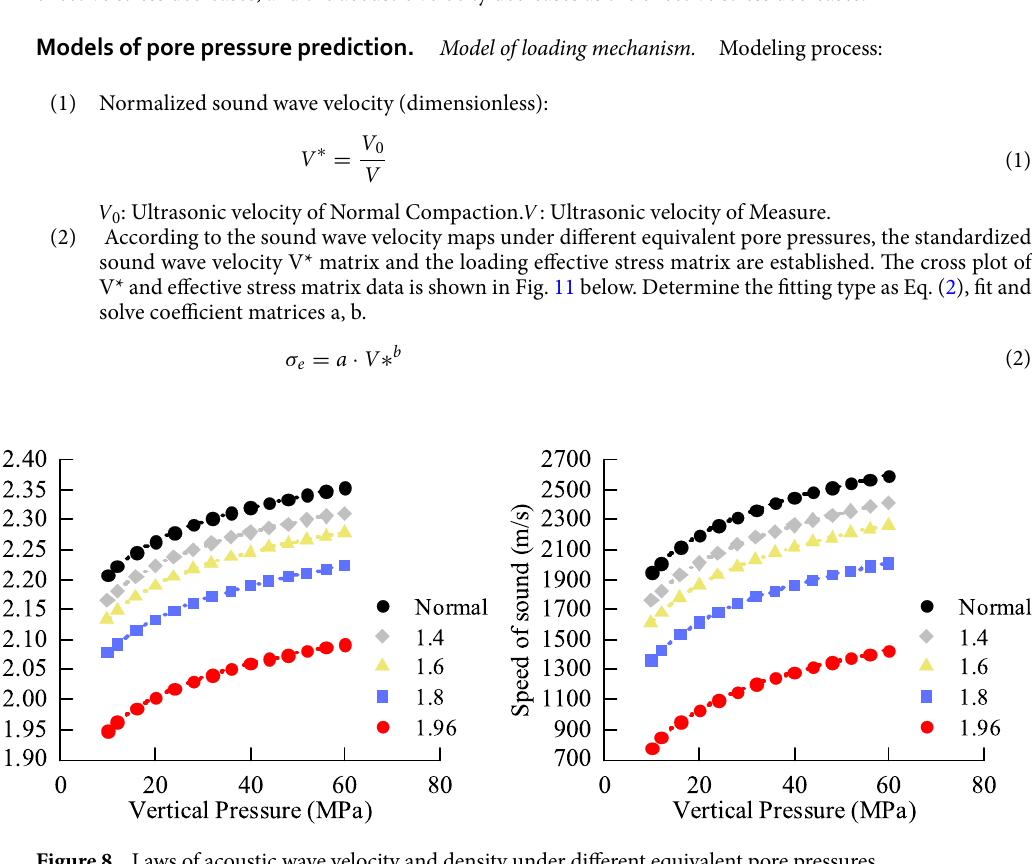
Figure 8. Laws of acoustic wave velocity and density under different equivalent pore pressures.